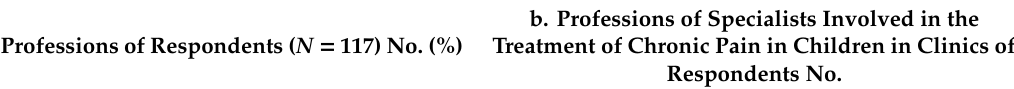
Table 1. Professions of questionnaire respondents ( a ) and professions of specialists involved in treatment of chronic pain in children in respondents’ hospitals ( b ).